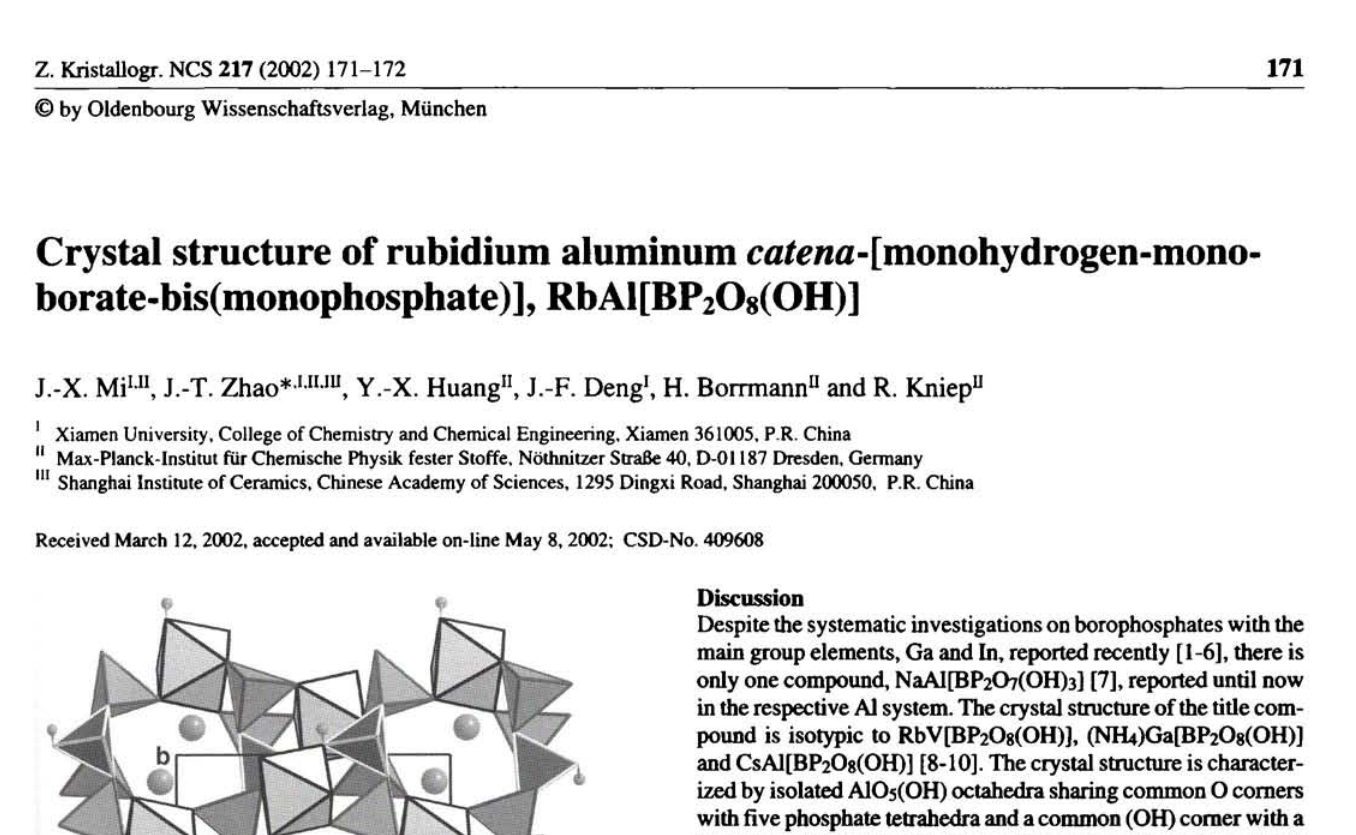
Table 1. Data collection and handling. Crystal: